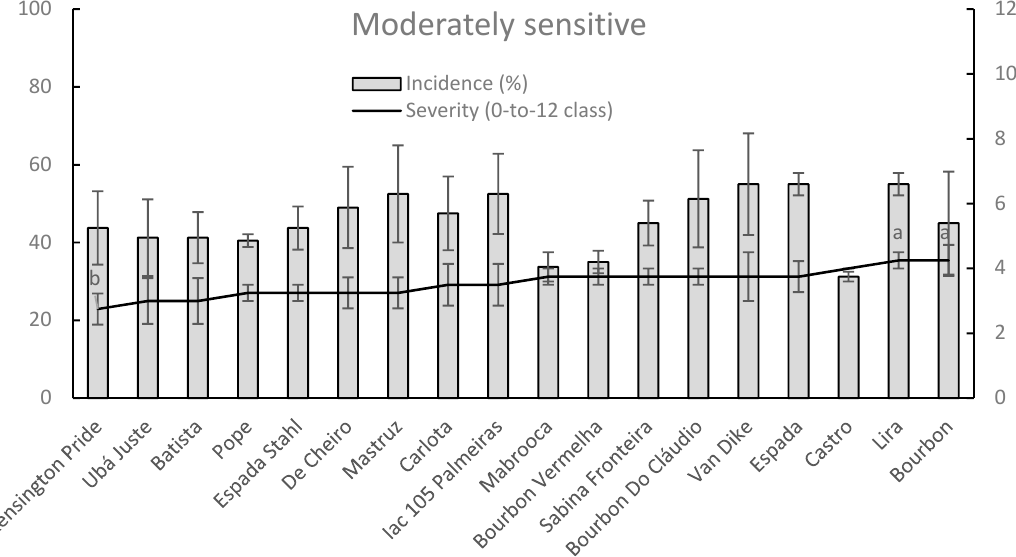
Figure 8. Column-line graphs on two axes comparing anthracnose incidence and severity caused by C. asianum within moderately sensitive mango cultivars. Data (± SE values) were collected and analyzed as above done for previous figures. Grey colors of columns, as well as the absence of letters above points of the line, clearly show the lack of significant differences according to both parametric and nonparametric approaches.